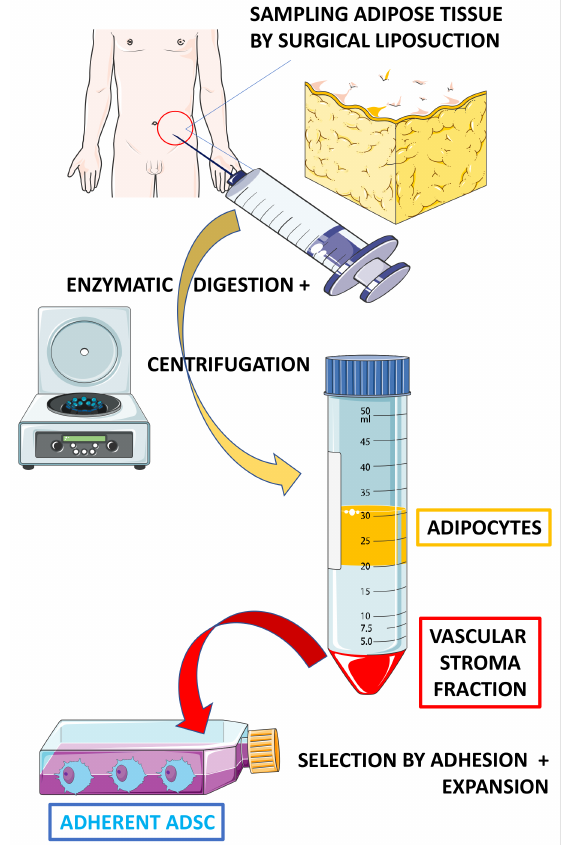
Figure 1. Method for isolating adipose-derived stem cells (ADSC). The adipose tissue is minced with fine scissors or a scalpel, then washed, treated with collagenase and centrifuged. The resulting pellet (serum vascular fraction of hematopoietic, endothelial, vascular smooth muscle, fibroblastic and immature cells, AND ADSCs) is then resuspended in a complete medium before seeding in a culture plate and cultured in a specific medium that facilitates ADSC